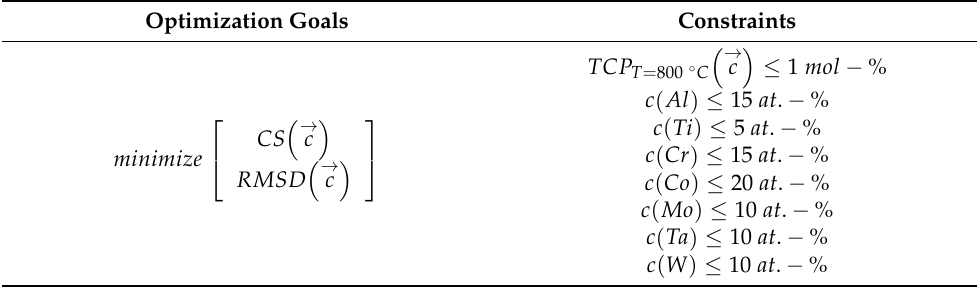
Table 2. Definition of optimization problem. CS , RMSD , TCP , and root-mean-square deviation from reference alloy properties, fraction of TCP phases, and entire concentration range,